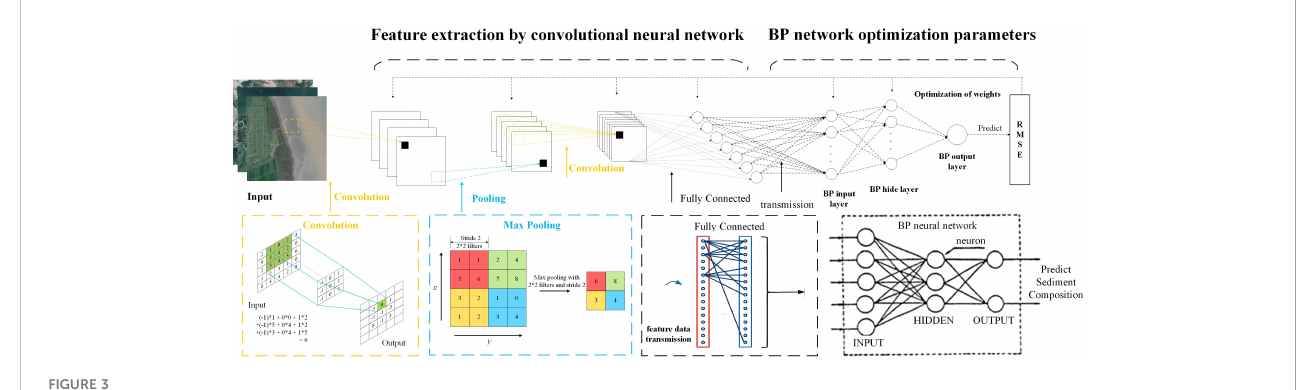
FIGURE 3 Structure of the Sediment Inversion